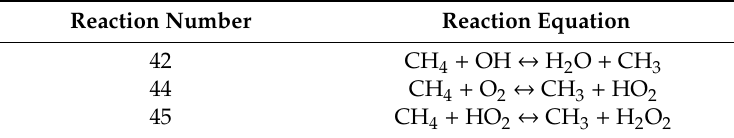
Table 2. Overview of methane reactions used for the adjustment in